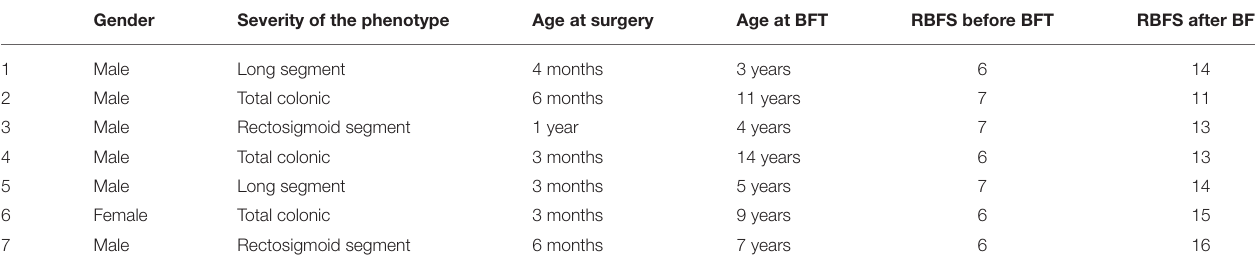
TABLE 6 | Demographic characteristics and clinical spectrum of the seven patients who had a poor prognosis after six sessions.